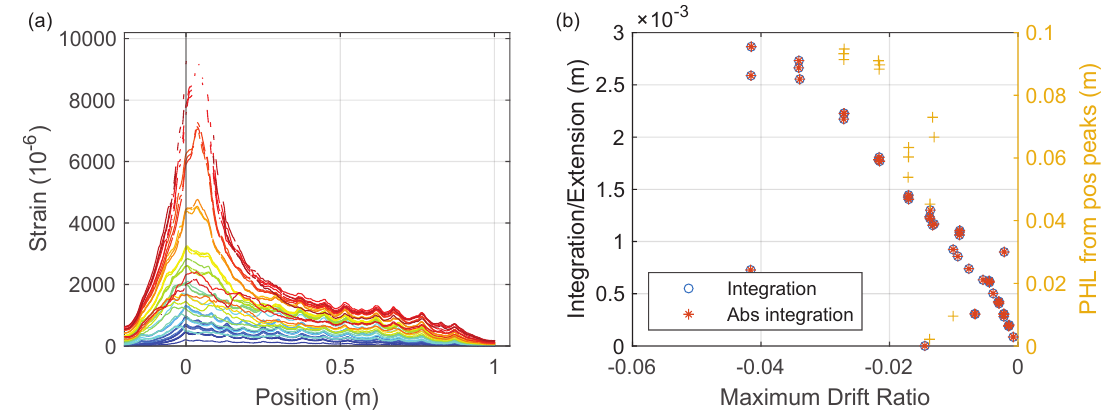
Figure 26. ( a ) Strain measurements at positive peaks of Beam Left (Silicon-PFA). ( b ) Proposed damage indices from maximum DFOS strain readings vs. maximum drift.